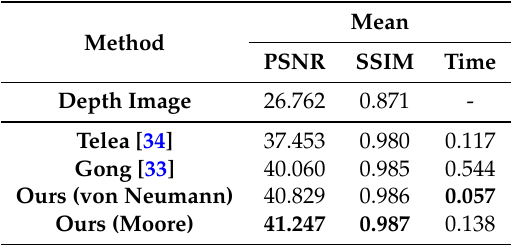
Table 3. Quantitative evaluation results using the Tsukuba Stereo Dataset. The best performance is highlighted in